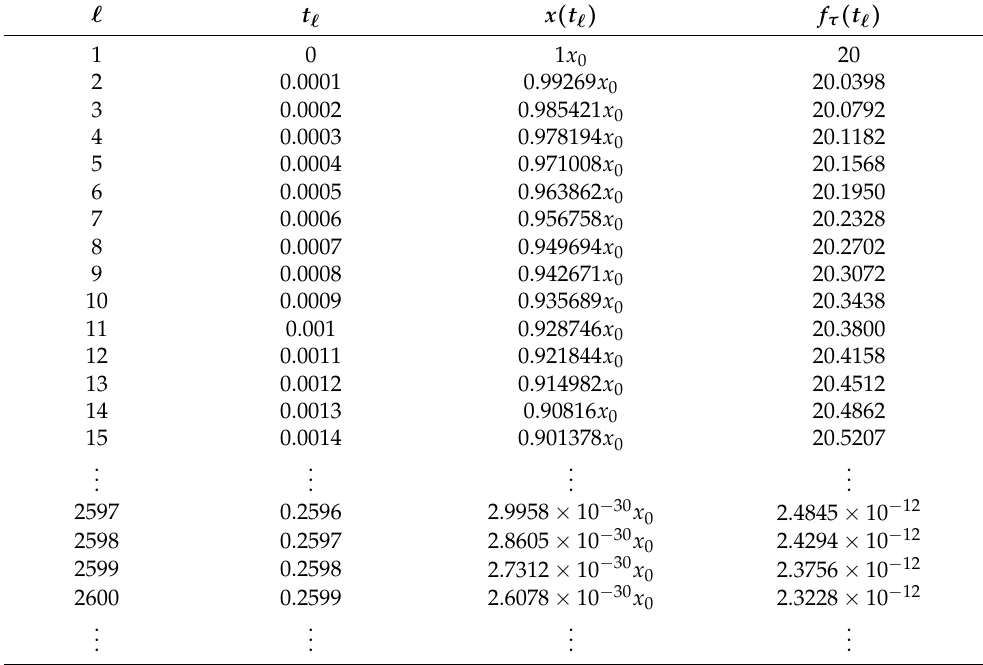
Table 3. Values of x ( t ) and f ( t )